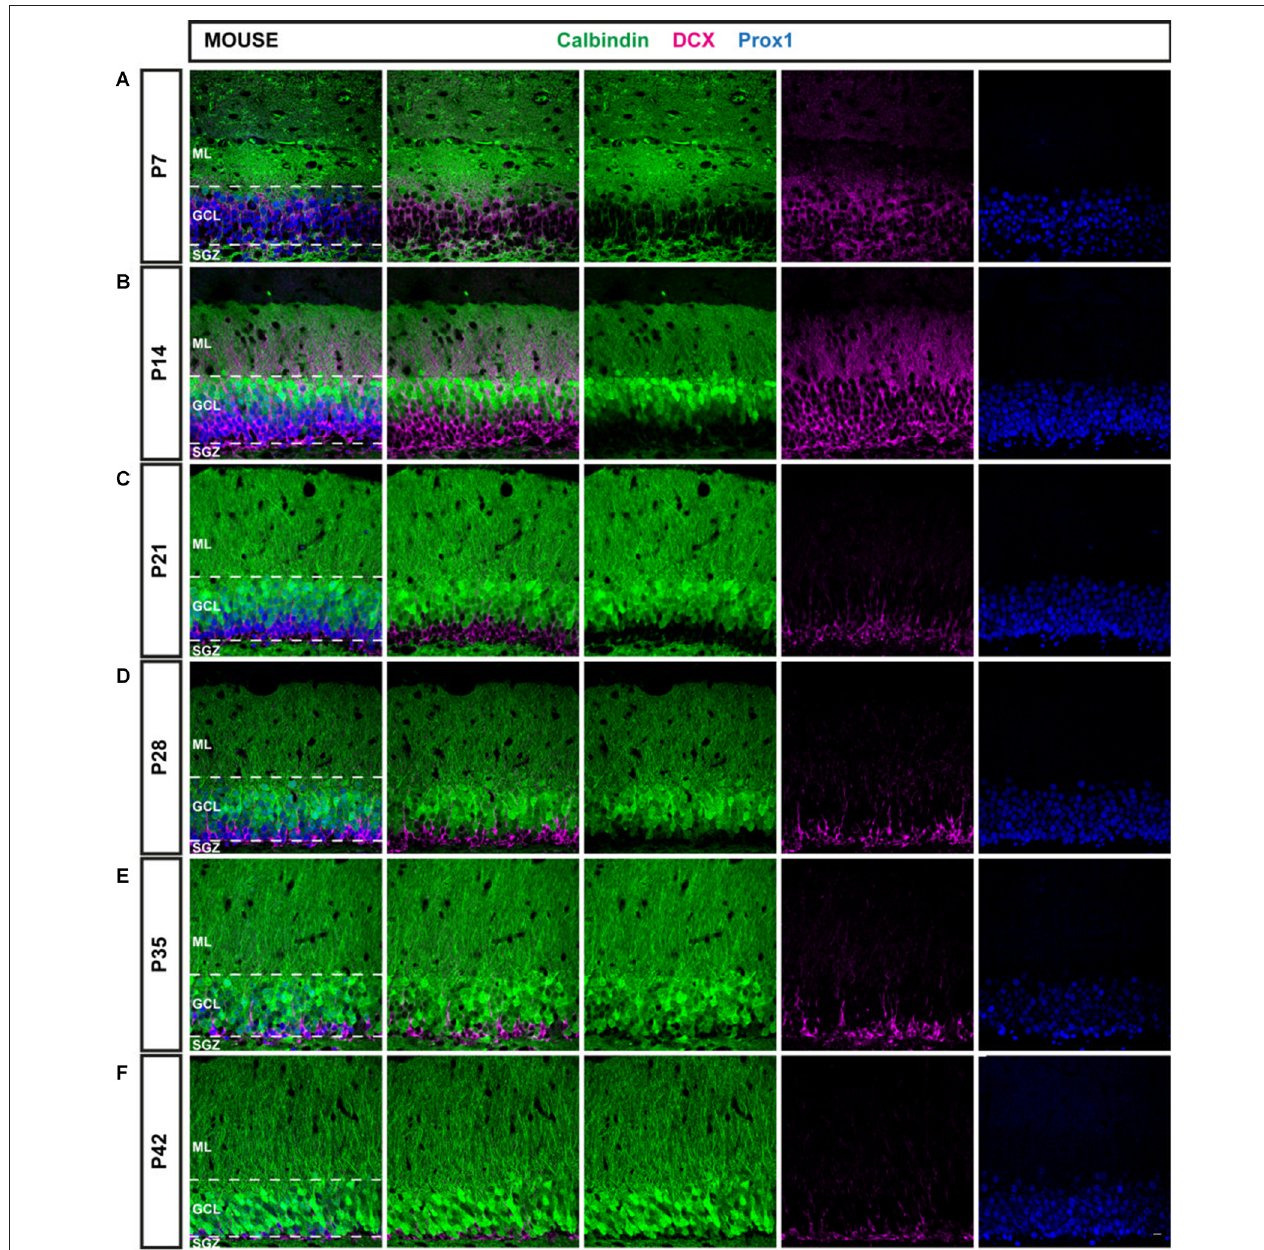
FIGURE 1 | Immunohistochemical illustration of calbindin (CB), doublecortin (DCX), and prospero-related homeobox 1 (Prox1) distribution in the postnatal dentate gyrus (DG) of the mouse. (A–F) Immunostainings of the postnatal mouse DG show increasing maturation from P7 to P42, as the proportion of mature CB-positive cells (green) increased while the number of young, immature DCX-expressing cells (magenta) was reduced over time. The granule cell (GC) marker Prox1 (blue) was expressed in both mature and immature GCs at all time points. Scale bar: 10 µ m.